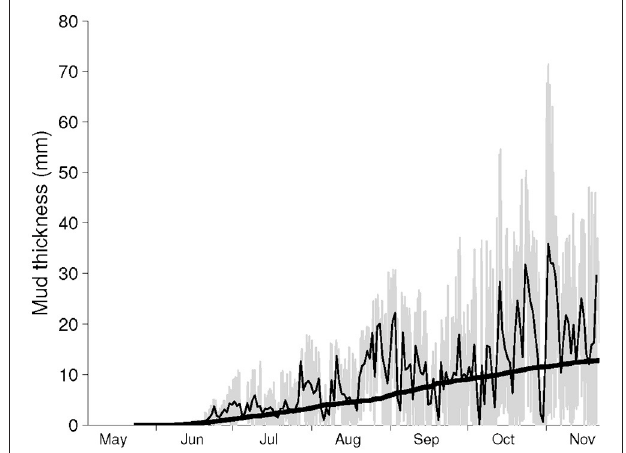
FIGURE 9 | Example time series for the simulated mud thickness at one point within the cage arrays at location 2. Gray line: values of mud thickness with resuspension plotted at 6 h intervals. Thin black line: daily running means of the mud thickness with resuspension. Heavy black line: daily values for simulated mud thickness without